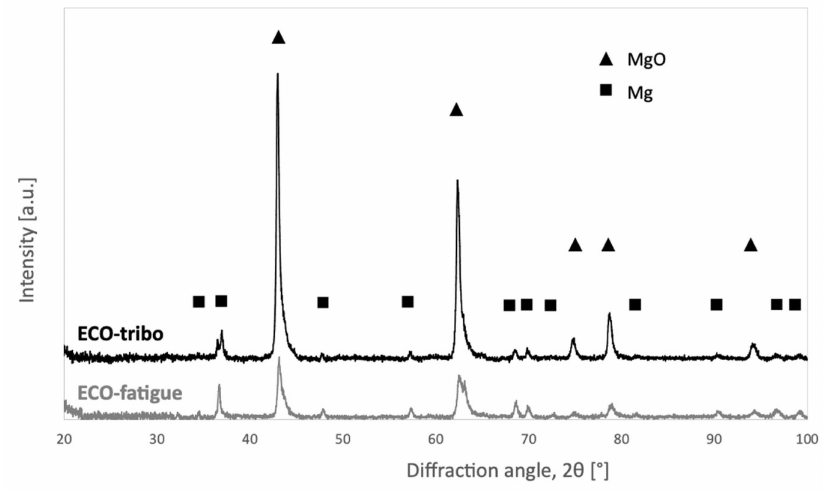
Figure 5. X-ray diffraction patterns, representative of the through-thickness composition of ECO layers on cast EV31A-T6.